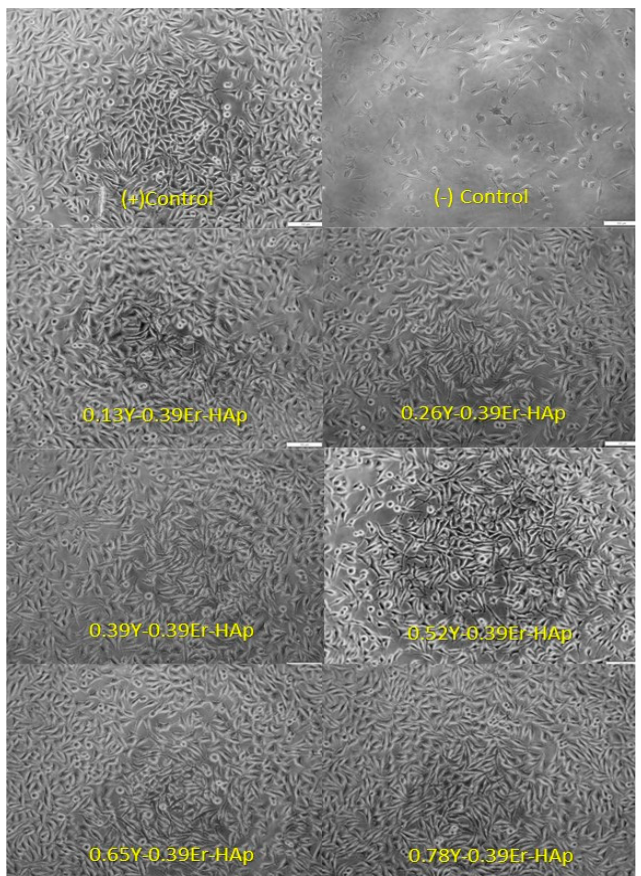
Figure 10. Optic microscope images for all the samples exposed to the L-929 cells .